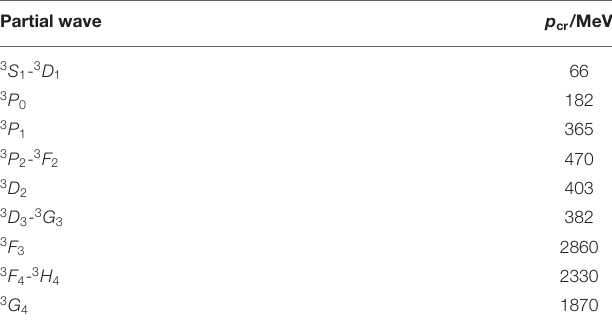
TABLE 1 | Estimate of the critical values p cr of the relative momentum in the lowest 2 N triplet channels above which the OPE tensor force cannot be treated perturbatively